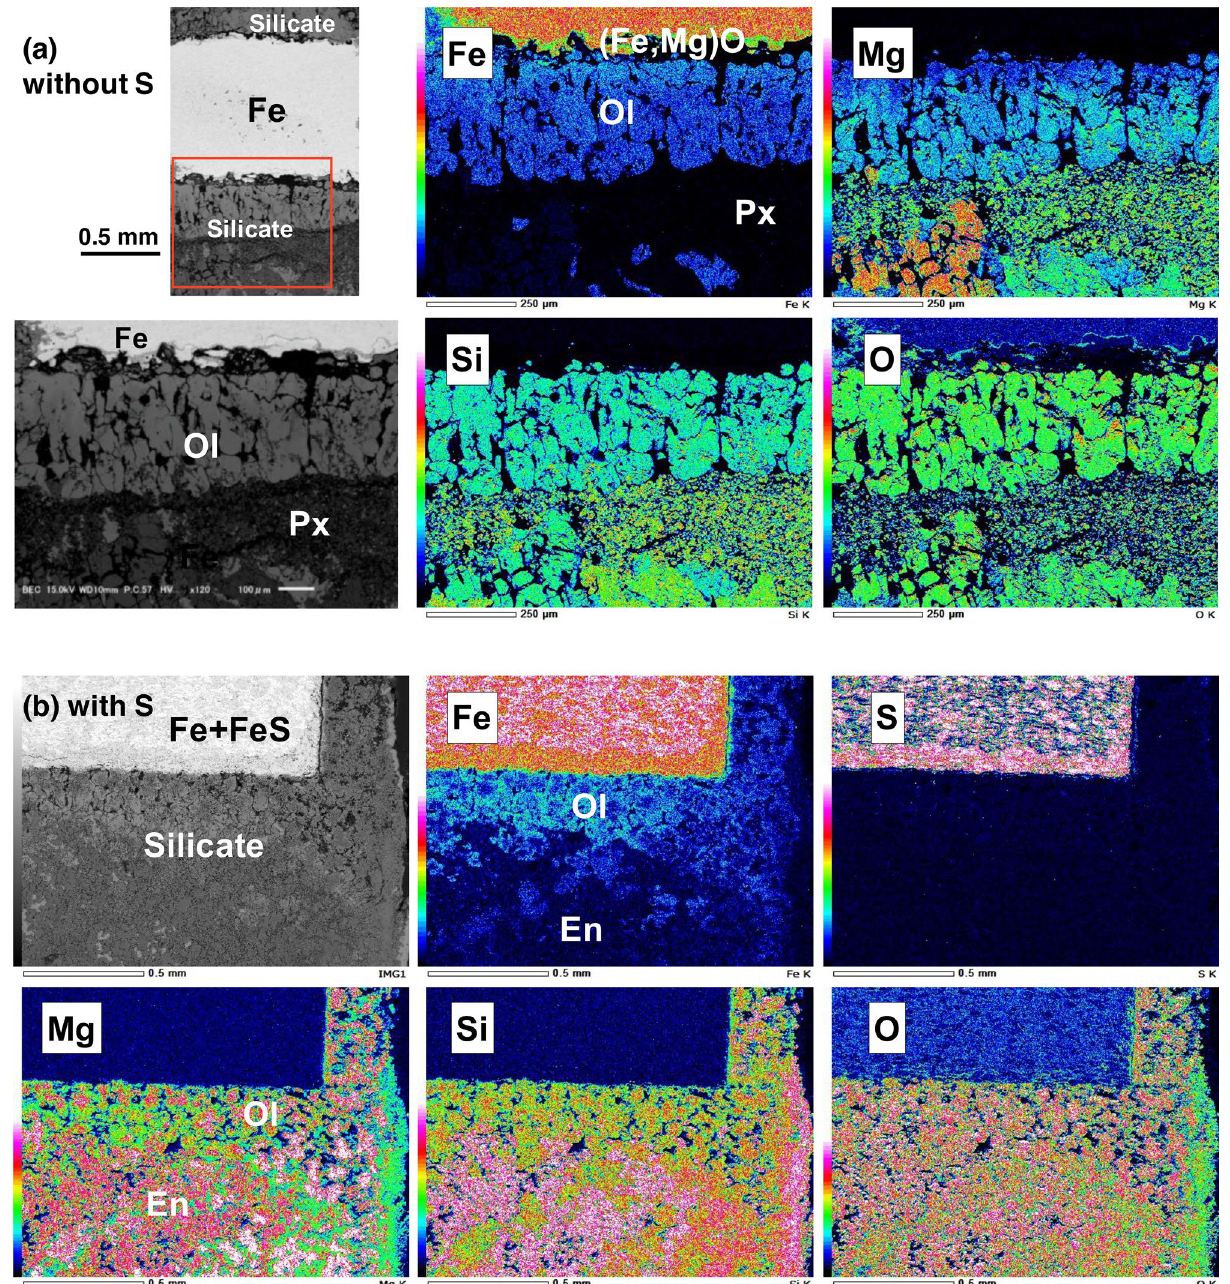
Figure 4. SEM elemental maps (Fe, Mg, Si, O and S) of hydrous samples, ( a ) without S recovered at 10.7 GPa and 1116 K (#A534) of the area surrounded by a red square in the upper left electron image and ( b ) with S recovered at 6.5 GPa and 1000 K (#A433). Ol olivine (Mg, Fe) 2 SiO 4 ; Px pyroxene (Mg, Fe)SiO 3 ; En enstatite MgSiO 3 . Olivine containing rich Fe located close to Fe whereas pyroxene was poor in Fe almost like enstatite and located far from the